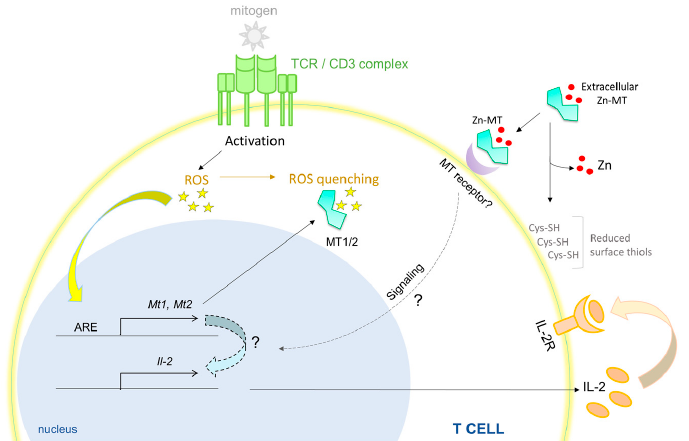
Figure 1. MTs (Metallothioneins) promote T cell survival and hyperproliferation. Activation of T cells